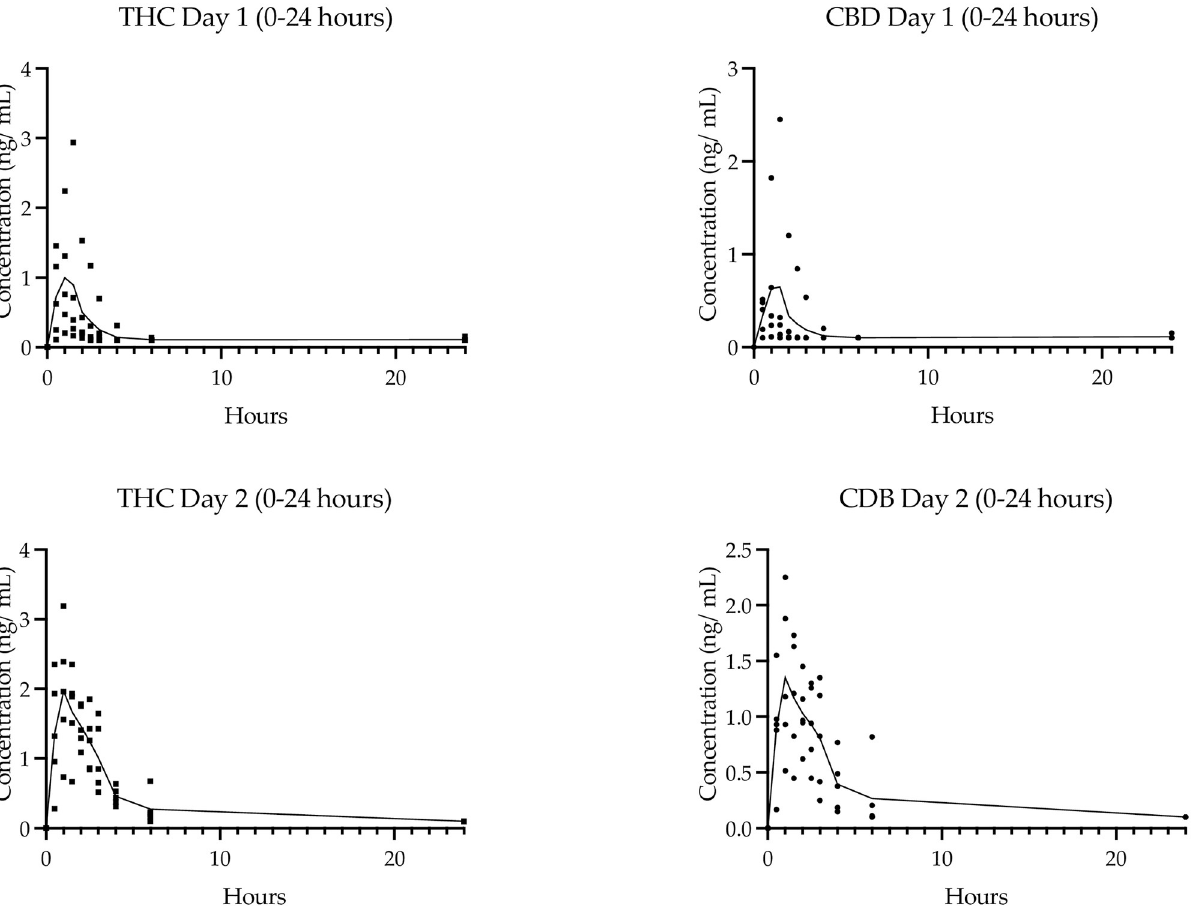
Fig 3. PK of Stage I SAD. Individual and median plasma concentration over time for Δ 9-THC (squares) and CBD (circles) on Day 1 (single dose of 2.5 mg Δ 9-THC/2.5 mg CBD) and Day 2 (3-fold dose of 7.5 mg Δ 9-THC/7.5 mg CBD).